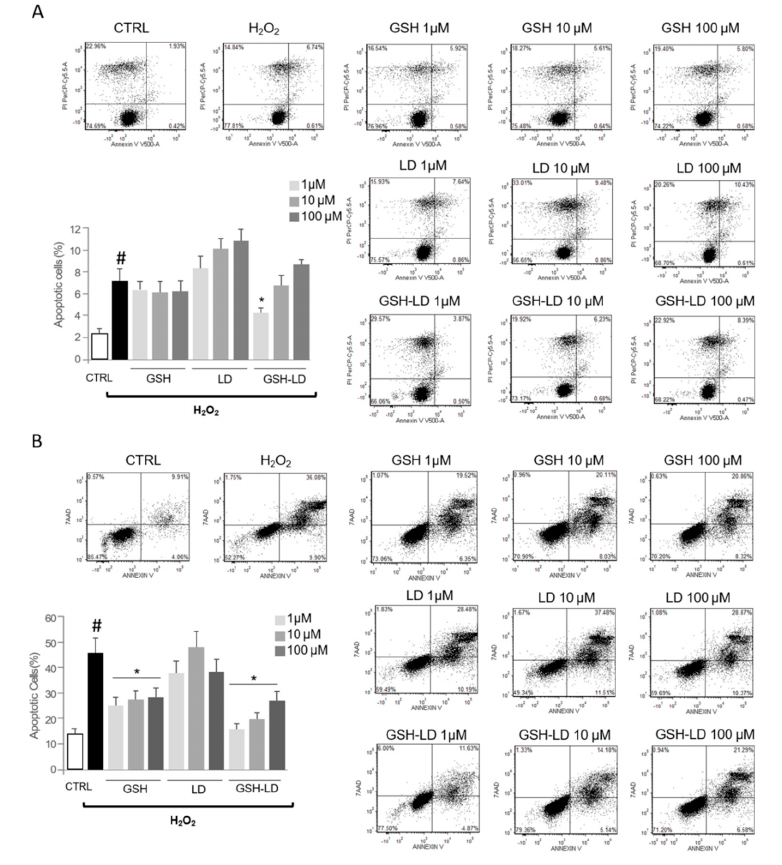
Figure 5. E ff ects of compounds on H 2 O 2 -induced apoptosis in neuroblastoma cell line. E ff ects of GSH, LD and GSH-LD on H 2 O 2 -induced apoptosis on ( A ) U SH-SY5Y and ( B ) D SH-SY5Y cells. Cells were treated with di ff erent concentrations of compounds (1, 10 and 100 µ M) for 1 h, and then exposed to H 2 O 2 (500 µ M) for 4 h. An Annexin V assay was used for apoptosis detection. Data are presented as the mean ± standard deviation ( n = 6). # p < 0.01 vs. CTRL; * p < 0.01 vs. H 2 O 2 -treated